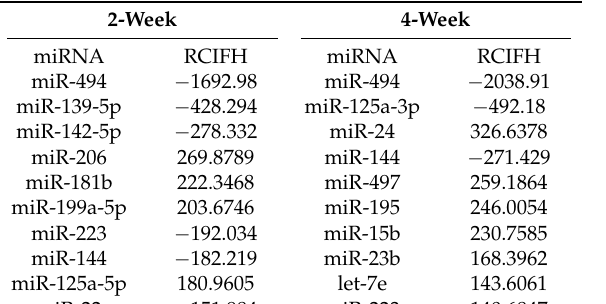
Table 1. The top 10 high miRNA contribution to impaired fracture healing (RCIFH) microRNAs (miRNAs) at 2- or 4-week (|log 2 FC| ≥ 1). A positive RCIFH miRNA promotes bone fracture healing, while a negative RCIFH miRNA inhibits it.